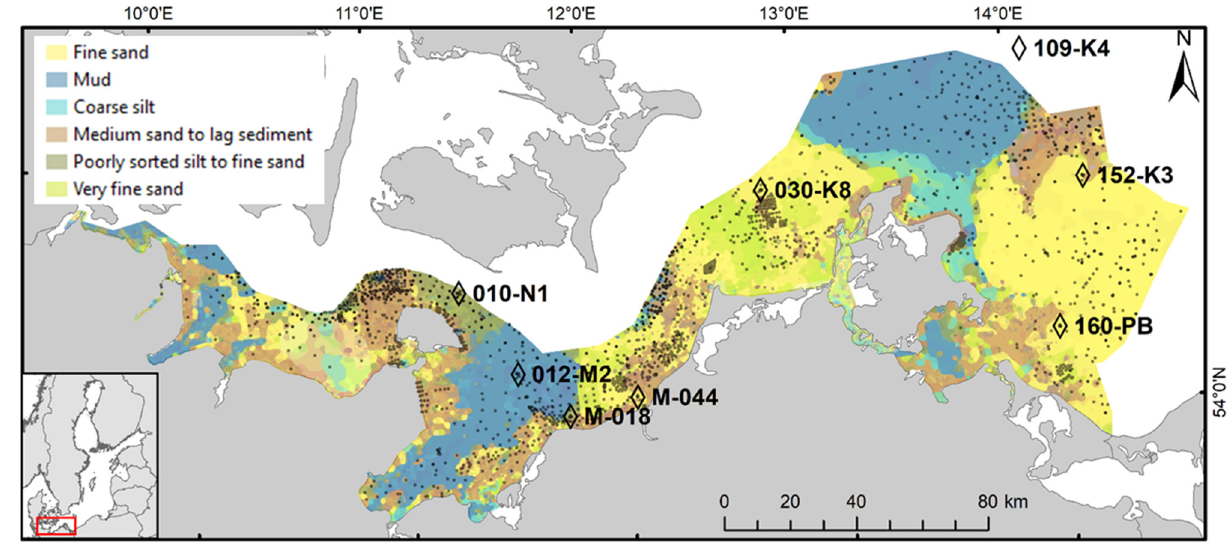
Figure 1. Map of the south-western Baltic Sea depicting the positions of the stations used as the reference dataset in this study (sampled in 2000–2020, shown by small grey dots), as well as long-term monitoring stations used to assess BIPc variability (shown by rhombus). The red rectangle indicates the location of the study area on a map of the Baltic Sea (lower left corner).